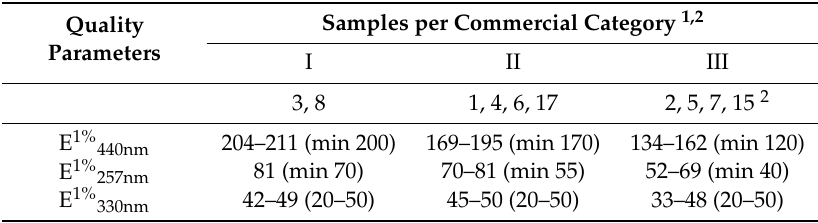
Table 3. Classification of 17 commercial samples according to the ISO 3632 quality categories [22] soon after the NMR analysis (07/2015).